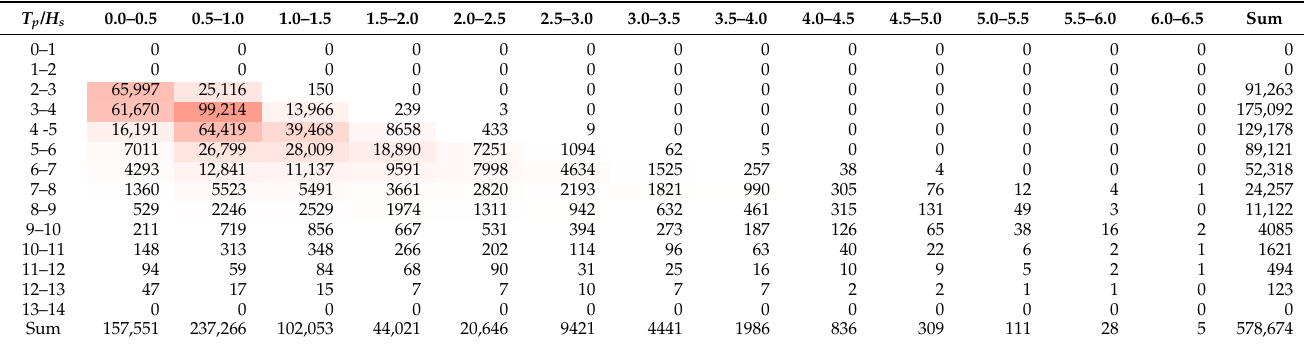
Table A6. Sea table for South Adriatic region (locations 22–39).